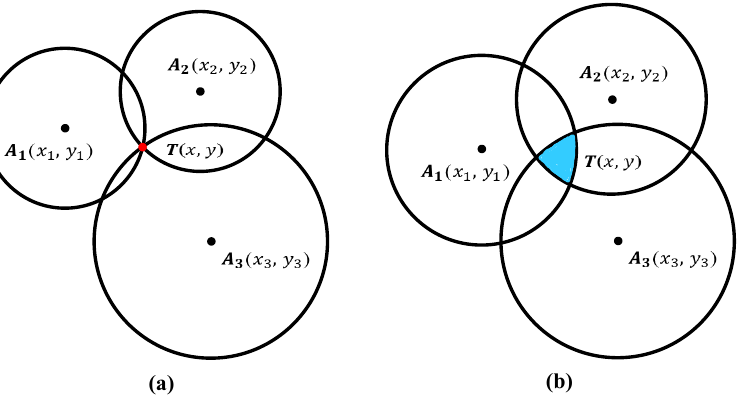
Figure 9. Schematic diagram of the trilateral centroid positioning algorithm. The black point represents the position of the anchor. ( a ) Ideal case: Three circles intersect at a point. ( b ) Non- ideal case: Three circles do not intersect at a point. The blue area indicates an error in the distance